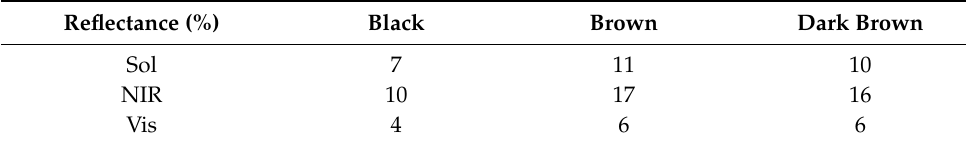
Table 5. Experimental reflectance measurements of road surfaces. Reflectance (%) Black Brown Dark